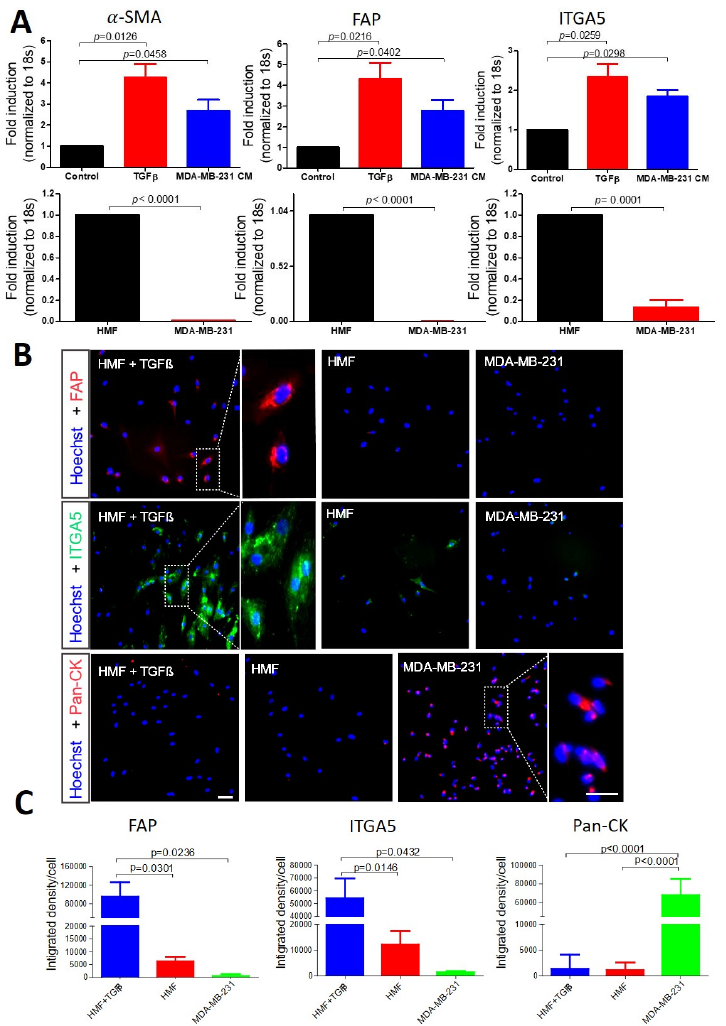
Figure 1. Biomarkers to identify circulating CAFs and tumor cells. ( A ) Gene expression analysis using qPCR for α‐ SMA, FAP and ITGA5 in activated and non ‐ activated HMFs with TGF β or condi ‐ tional medium collected from cancer cells and human MDA ‐ MB ‐ 231 cancer cells. ( B ) Immunofluo ‐ rescence staining for FAP (red), ITGA5 (green) and pan ‐ CK (red) in non ‐ activated and TGF β‐ acti ‐ vated HMFs, as well as MDA ‐ MB ‐ 231 breast tumor cells; Hoechst (blue) represents nuclear staining. Scale bar, 100 μ m. ( C ) Bar graphs showing the quantitative analyses of each staining ( B ) analyzed